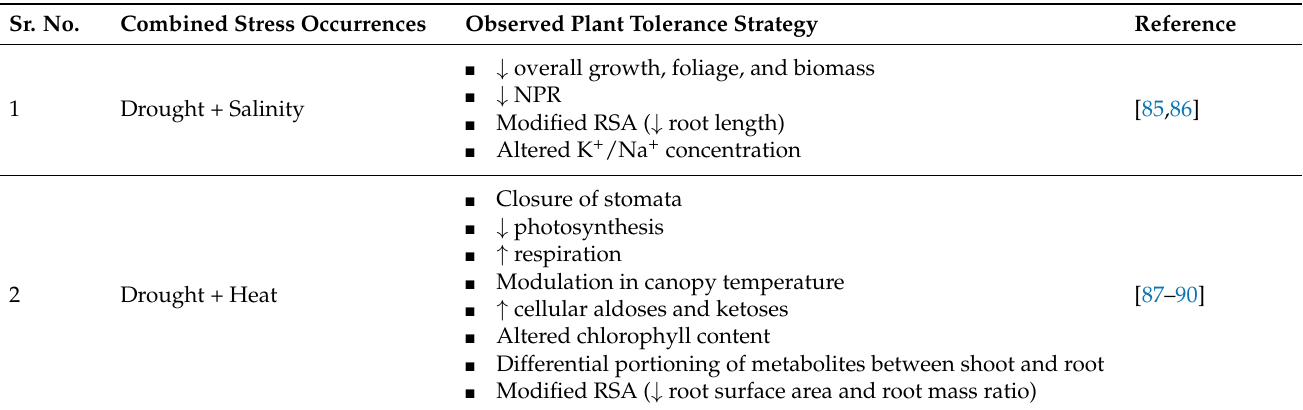
Table 1. Multi-omics mediated assessment of plant tolerance strategy towards various abiotic stress